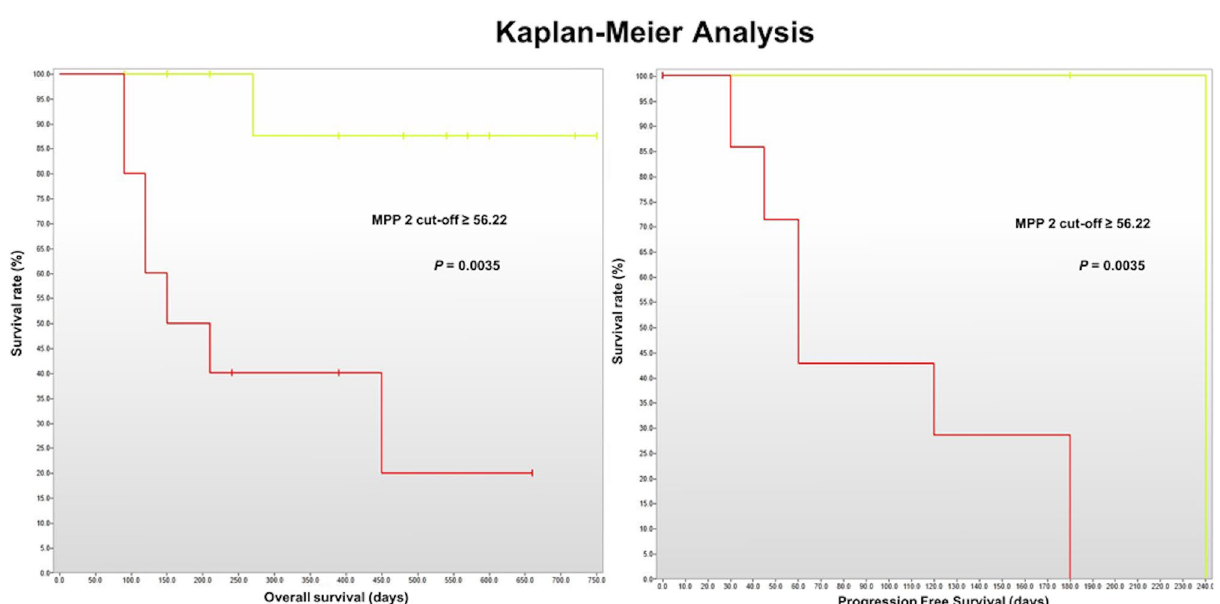
Figure 3. Figure shows results of Kaplan–Meier analysis for MPP Texture parameters at Spatial Filter Scale (SSF) 2 for Overall Survival (OS) and Progression Free Survival (PFS). When dichotomized at the optimal threshold identified in Kaplan–Meier analysis, MPP under 56.22 at fine scale (SSF = 2) was significantly associated with lower OS and PFS after administration of Pembrolizumab (red line), while MPP above 56.22 is significantly associated with higher OS and PFS (green line), P = 0.0035